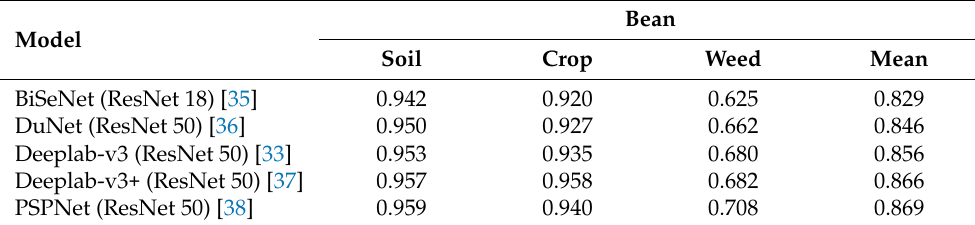
Table 4. Benchmark segmentation results for the acquired Bean dataset.